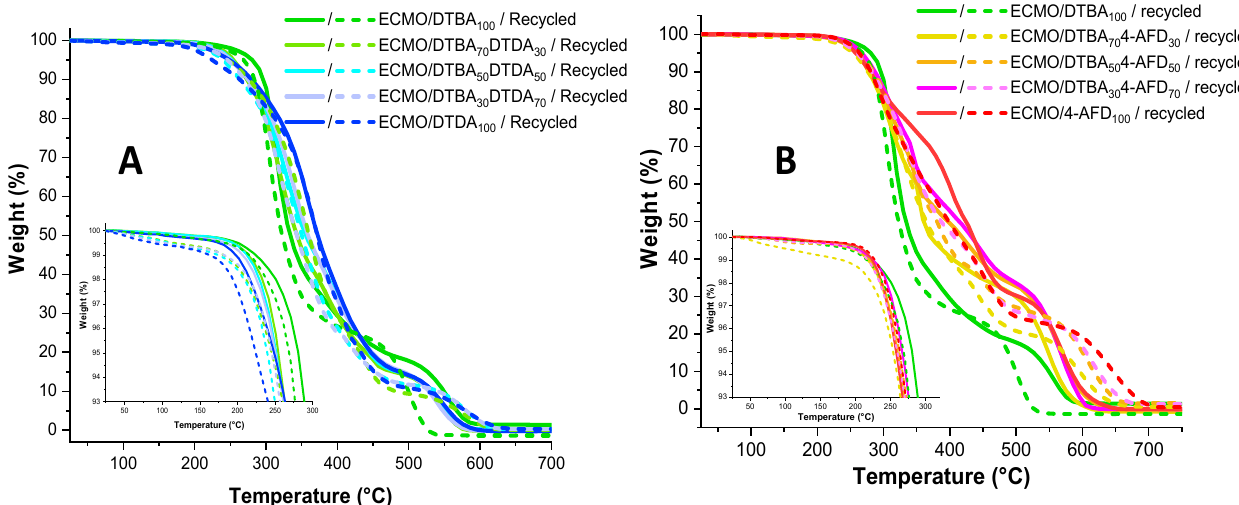
Figure 7. TGA and zoomed-in view of the T 5% area (from 25–300 °C) for the virgin and recycled ECMO thermosets: DTBA and DTDA combination ( A ) and DTBA and 4-AFD and mixtures ( B ). Table 3. T 5% for virgin and recycled